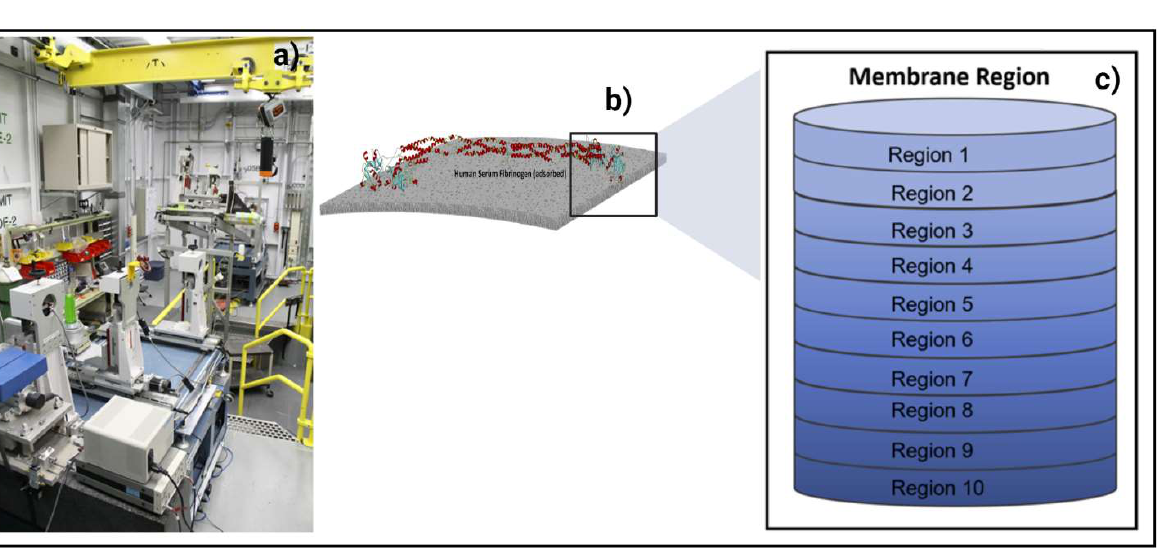
Figure 2. ( a ) Photo of the experimental SR-μCT system in BMIT hatch at the Canadian Light Source (CLS); ( b ) side view of membrane; and ( c ) layer-by-layer division of membranes in 10 regions.